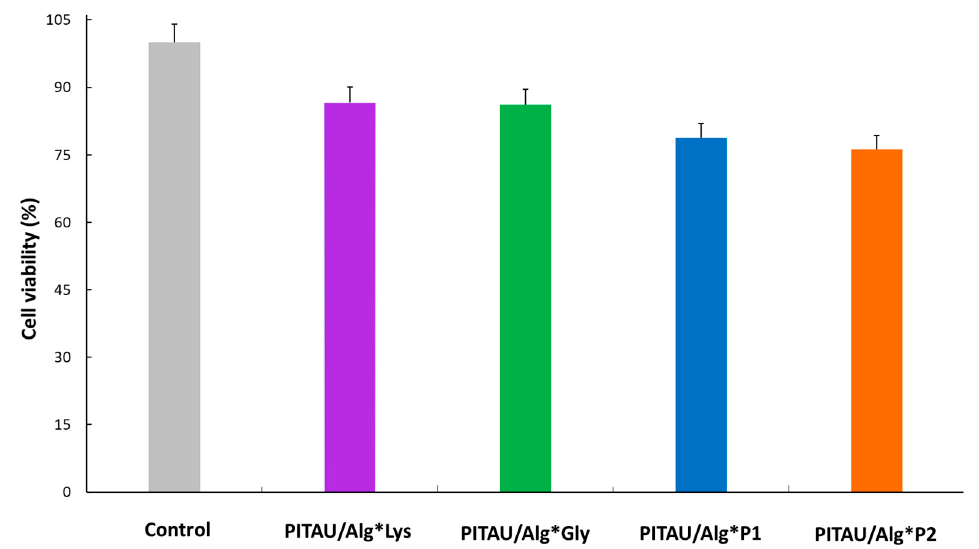
Figure 11. Viability of human fibroblast cells evaluated by MTT assay at 96 h. All data are expressed as a percentage with respect to the untreated control cells and are the mean of three independent experiments ± standard error of the mean